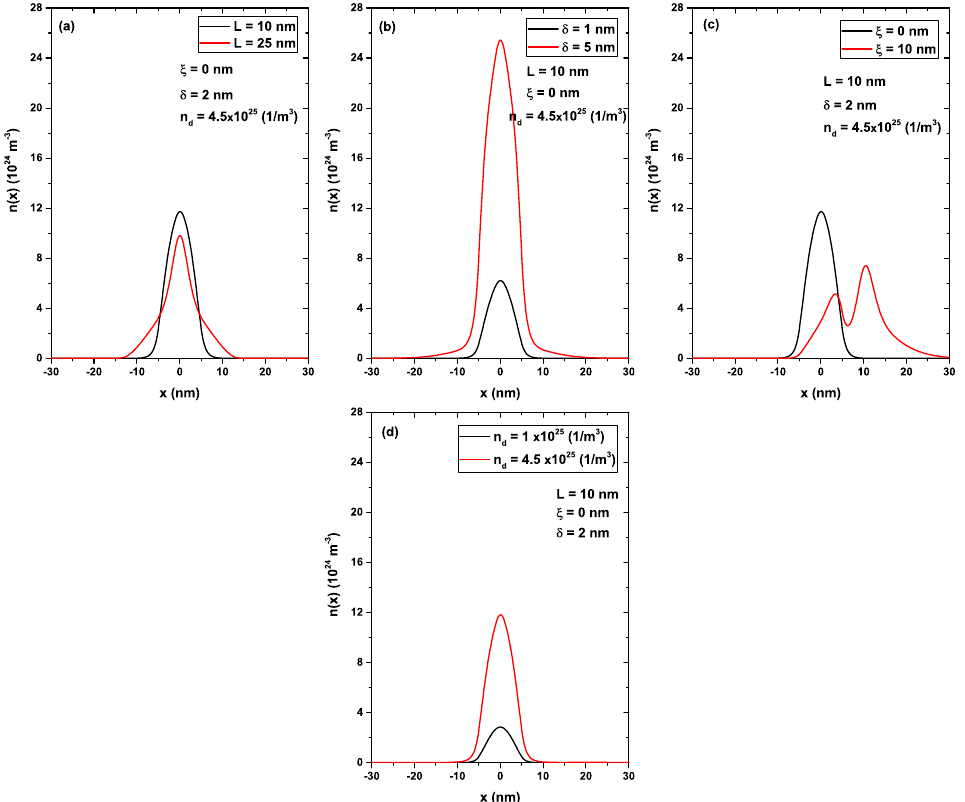
Figure 10. Electron density as a function of x -position. In ( a ) varying the L , in ( b ) varying the δ , in ( c ) varying the ξ , and in ( d ) varying the n d . In each case, when one parameter was changed, the others were set to L = 10nm, ξ = 0, δ = 2nm, and n d = 4.5 × 10 25 (1/m 3